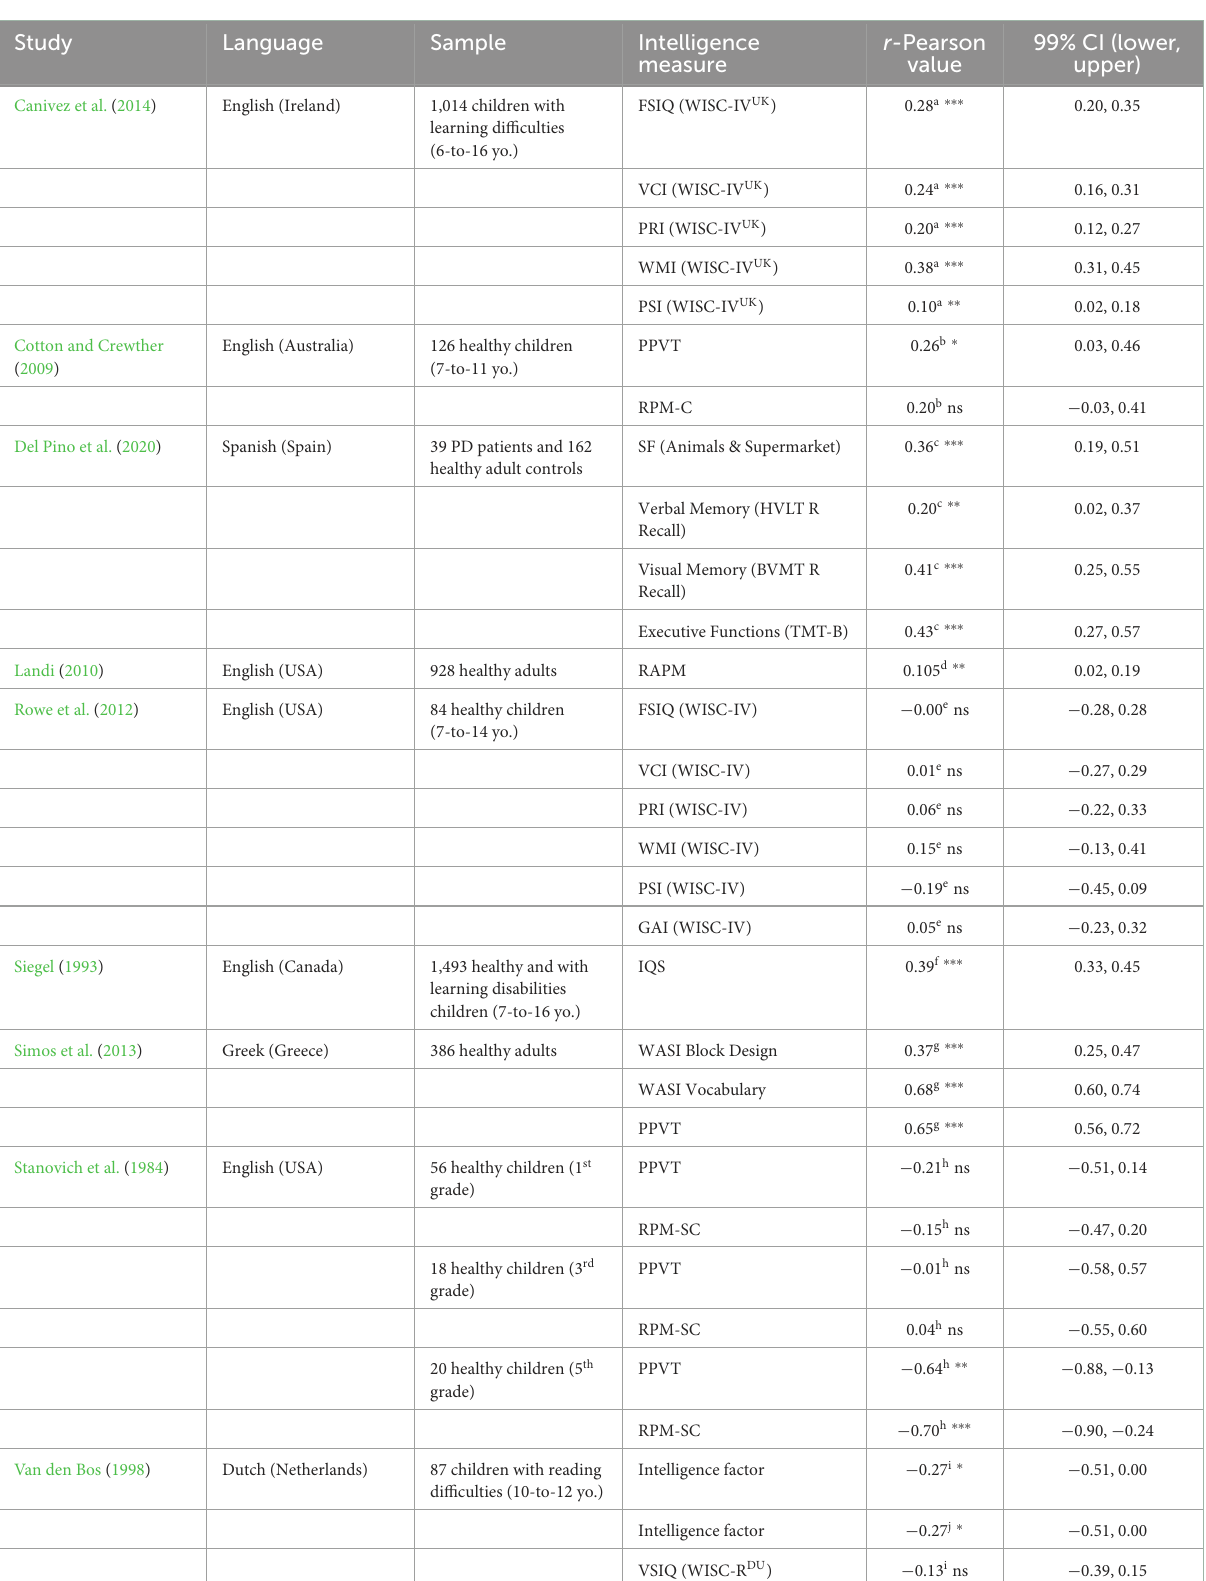
TABLE 1 Bivariate correlations found between intelligence scales/cognitive domains with PRW.